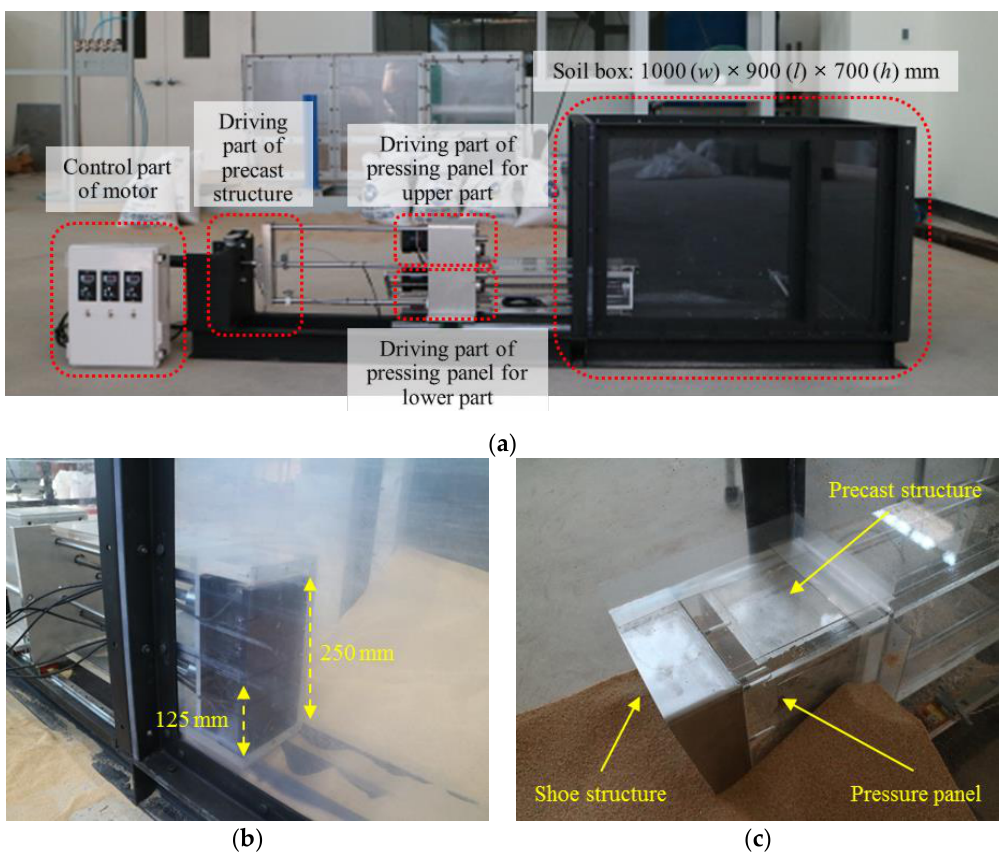
Figure 5. Experimental equipment for model test: ( a ) front view. ( b ) Tunnel model for two levels. ( c ) Joint part of precast and shoe structure.